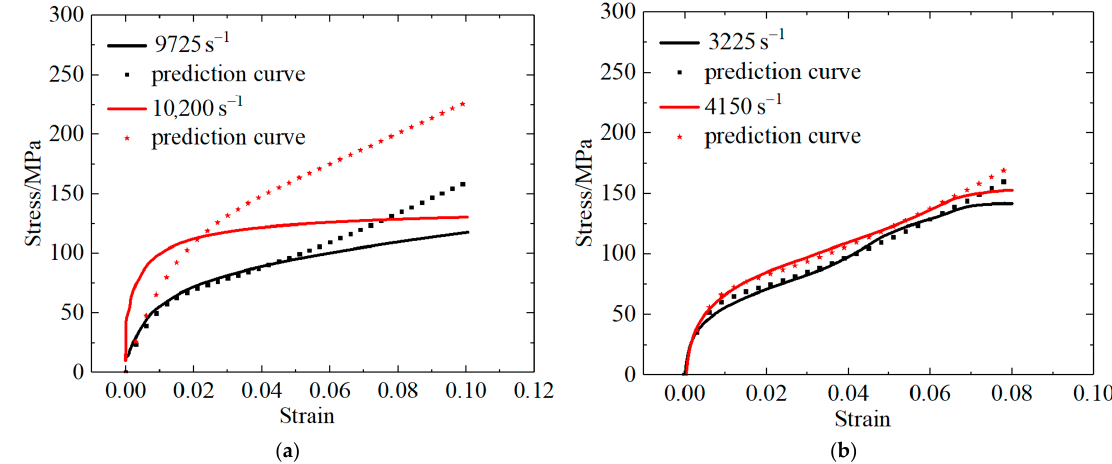
Figure 14. Comparison of theoretical prediction curve and experimental curve of ( a ) PLA; ( b ) PLA ‐ Cu.